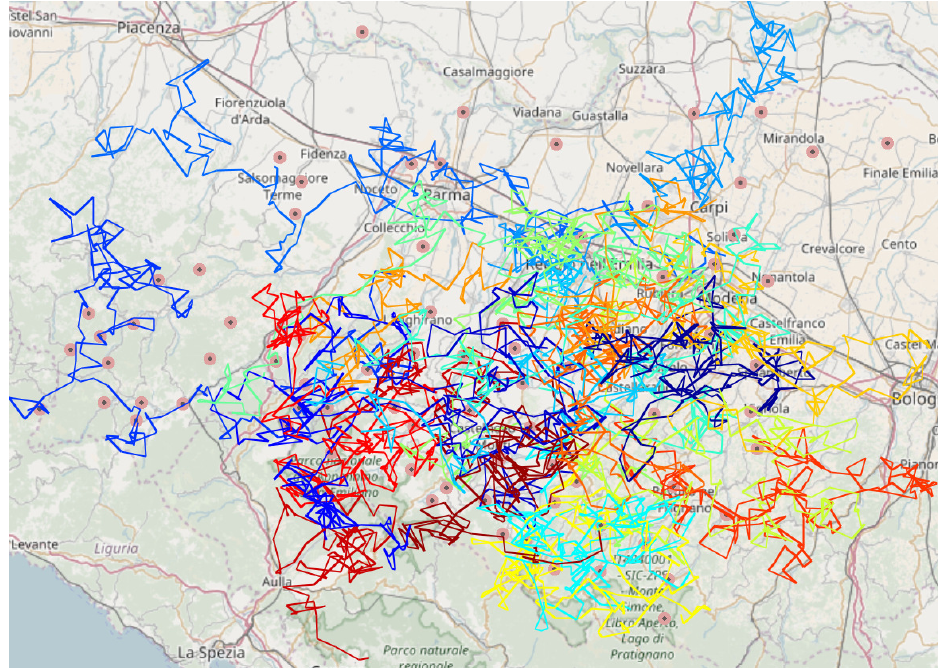
Figure 2. An example of 20 colored random walks together with the weather stations (pink dots) in Emilia-Romagna, Italy (obtained through OpenStreetMap [27]). The reader is referred to the electronic version of the article for interpretation of the colors in the figures.